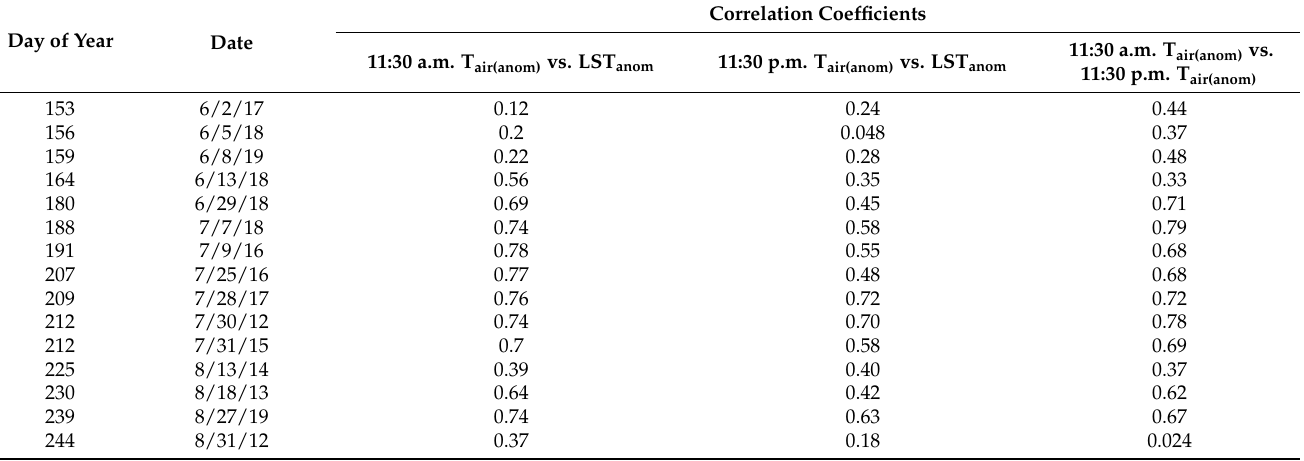
Table 3. Correlation coefficients between all three measures of temperature and 15 dates studied, arranged by day in the summer season. All of the correlation coefficients in the table are statistically significant ( p < 0.001).